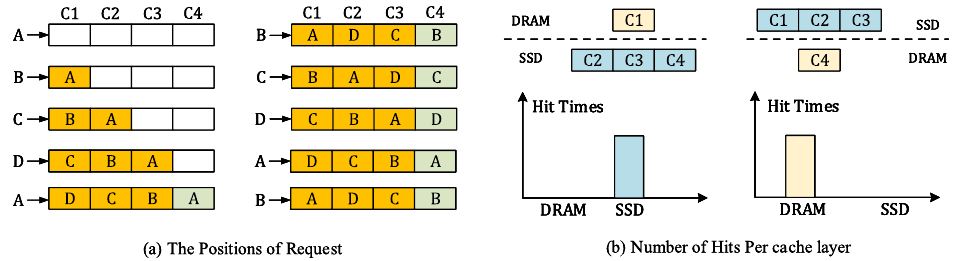
Figure 3. Access characterization of Performance Cliff.